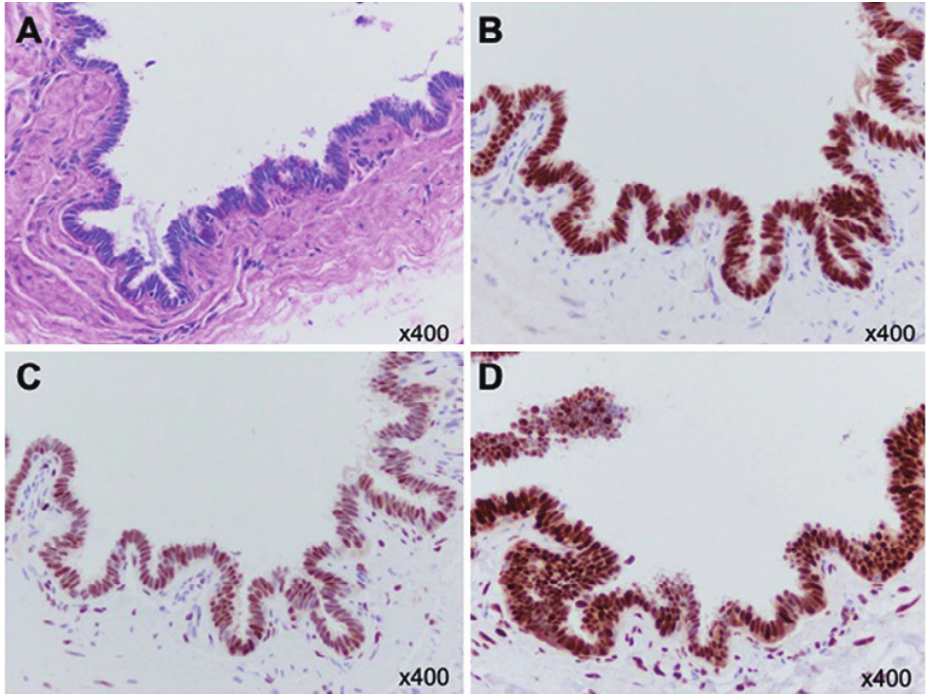
Figure 3. Histopathological findings of the resected cystic mass. ( A ) Hematoxylin and eosin staining revealed the presence of ciliated columnar epithelium inside the cyst wall, without cytologic atypia. ( B ) Immunohistochemical staining showed that the lining cells expressed estrogen receptors strongly and uniformly. ( C ) The lining cells strongly express the progesterone receptor. ( D ) The lining cells strongly and uniformly express the paired box gene